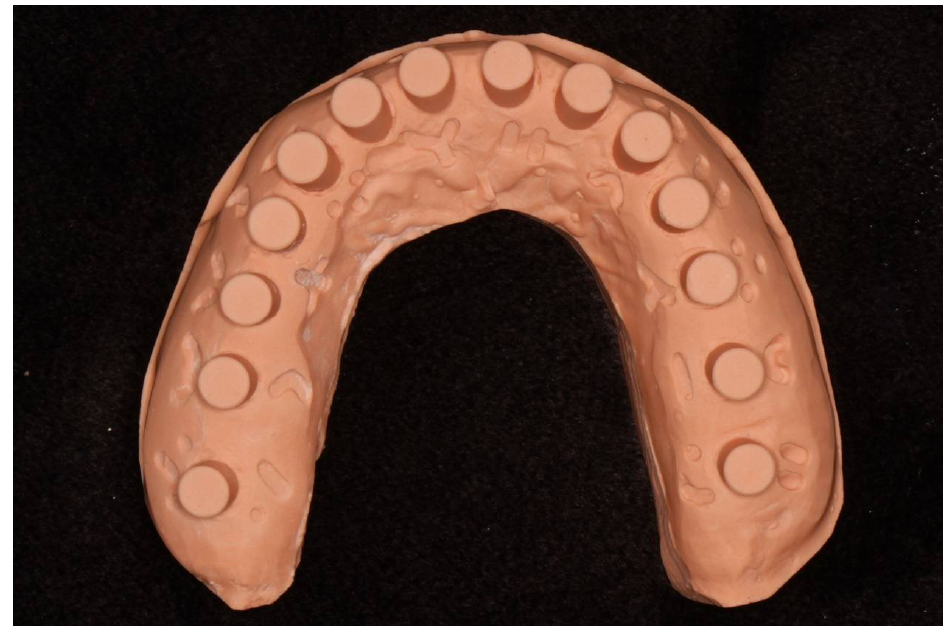
Appl. Sci. 2021 , 11 , x Figure 2. Definitive cast fabricated by conventional impression. Figure 2. Definitive cast fabricated by conventional impression.